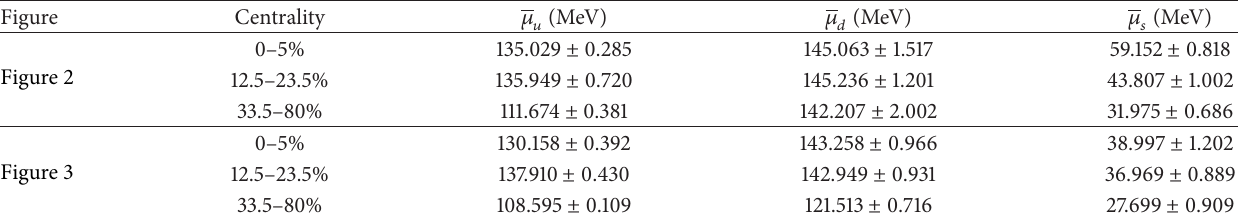
Table 4: Mean values of quark chemical potentials obtained from Figures 2 and